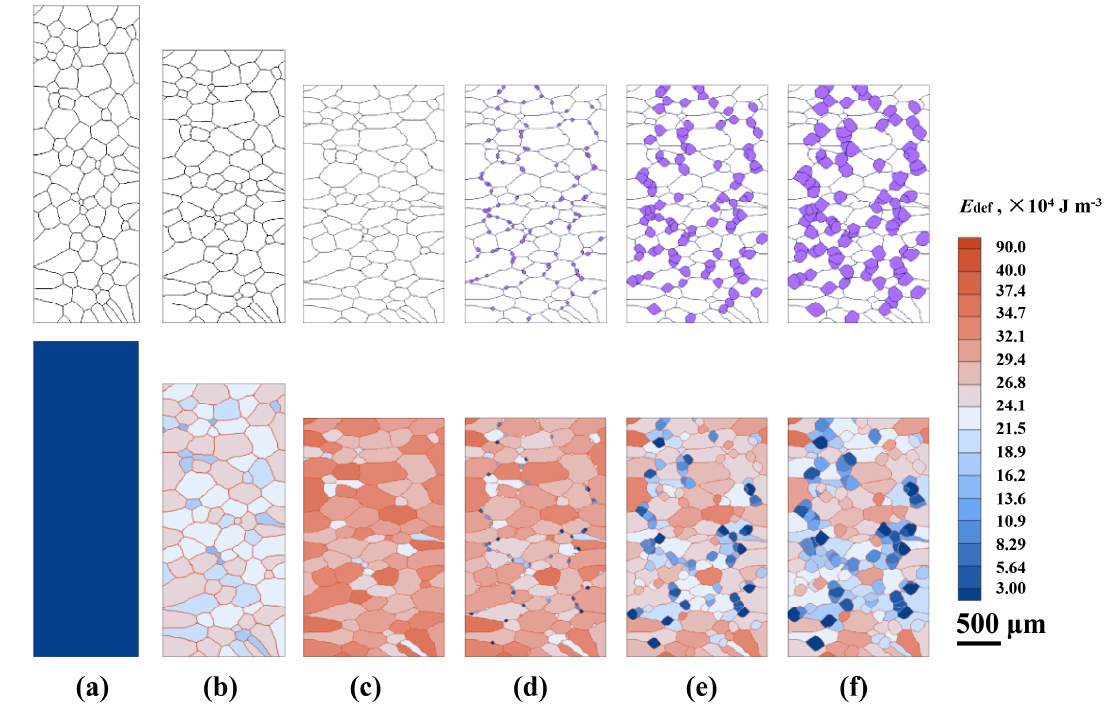
Figure 6. CA simulated evolution of the grain structure (upper row) and deformation-stored energy (lower row) during the 1st pass and interval: ( a ) t = 0.0 s; ( b ) t = 0.05 s; ( c ) t = 0.09 s, the end of deformation; ( d ) t = 1.0 s; ( e ) t = 3.0 s; ( f ) t = 4.1 s. In the upper row, the white and purple grains represent the initial and recrystallized grains generated in the 1st pass and interval, respectively. The horizontal and vertical directions are the rolling and compression directions, respectively.